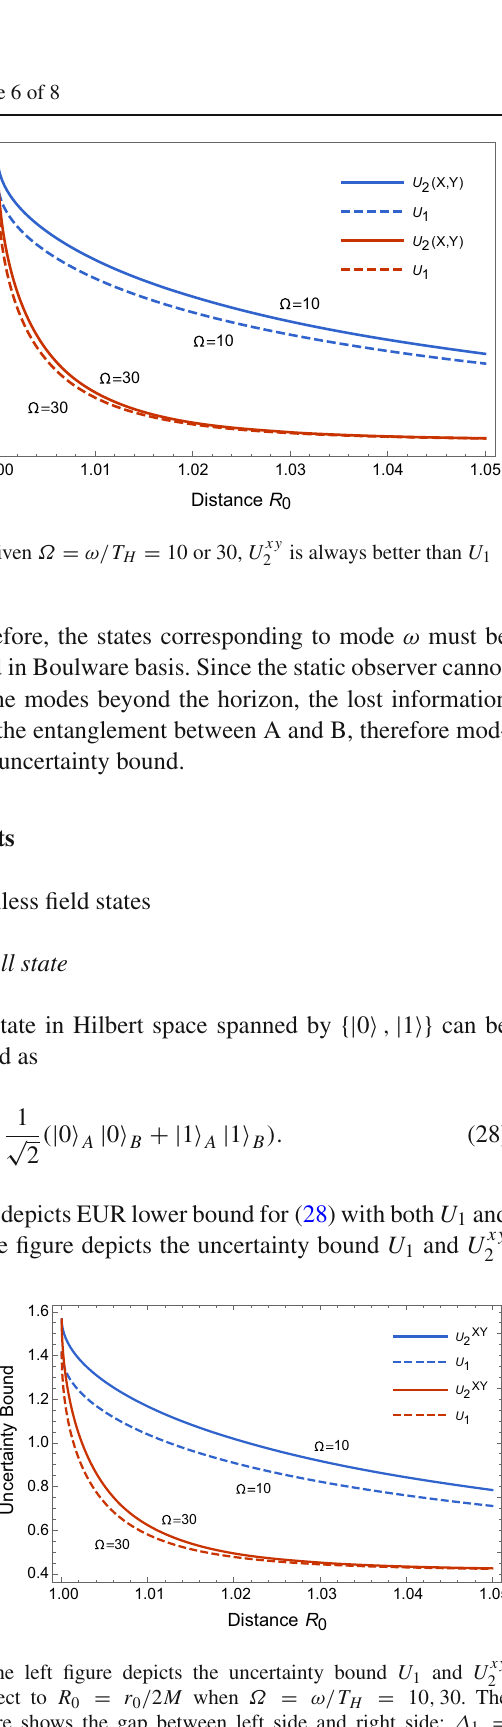
= H ( X | R ) + H ( Y | R ) − U xy 2